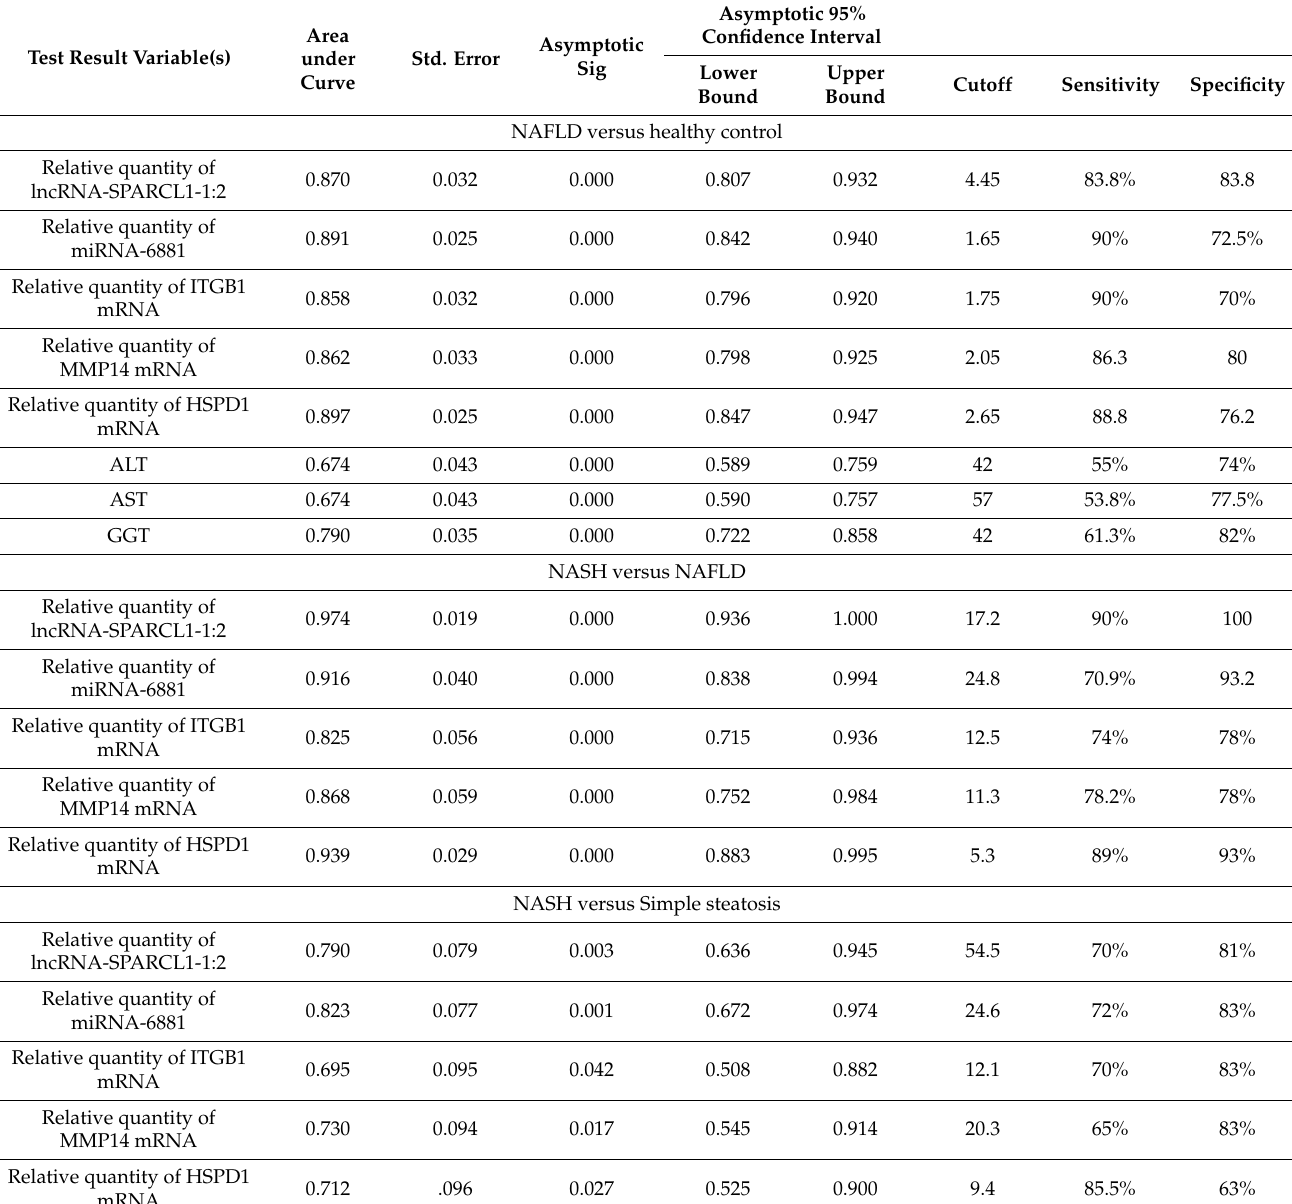
Table 2. Performance characteristics of the investigated RNA